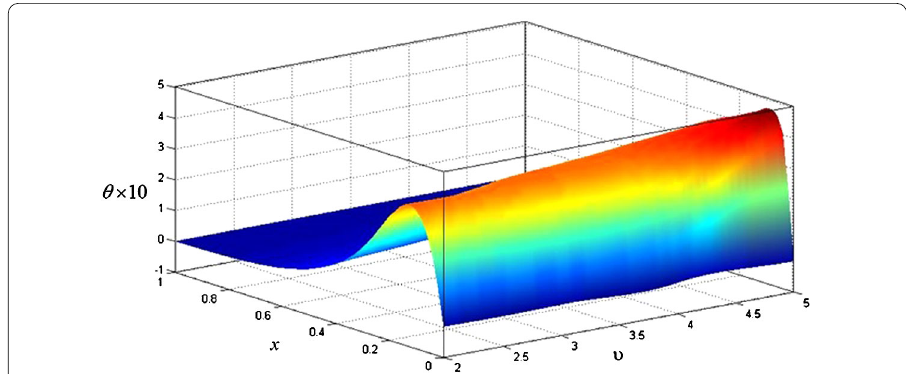
Figure 6 The temperature increment distribution for a wide range of heat source speed when y = z = 0.5